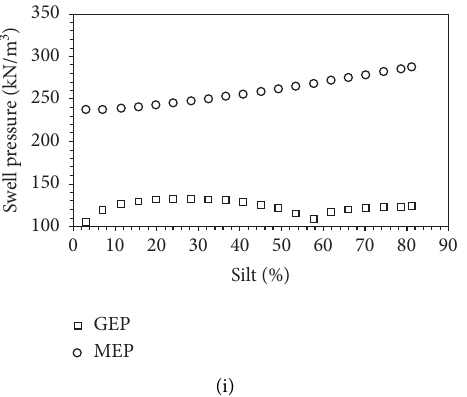
Figure 10: (a) Sensitivity analysis; Parametric study of (b) clay fraction, (c) Atterberg limits, (d) maximum dry density, (e) optimum moisture content, (f) swell percent, (g) natural water content, (h) sand, and (i) silt, for GEP and MEP models,